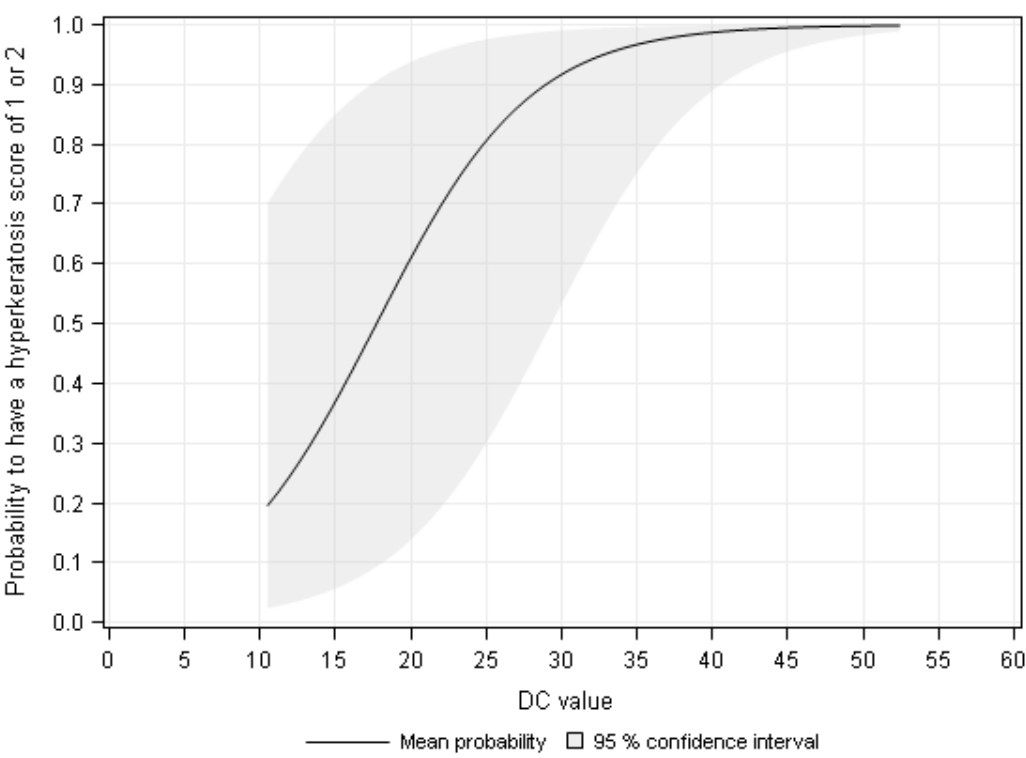
Figure 4. The probability to have a hyperkeratosis score of 1 or 2 depending on the measurement value of the dielectric constant (DC).